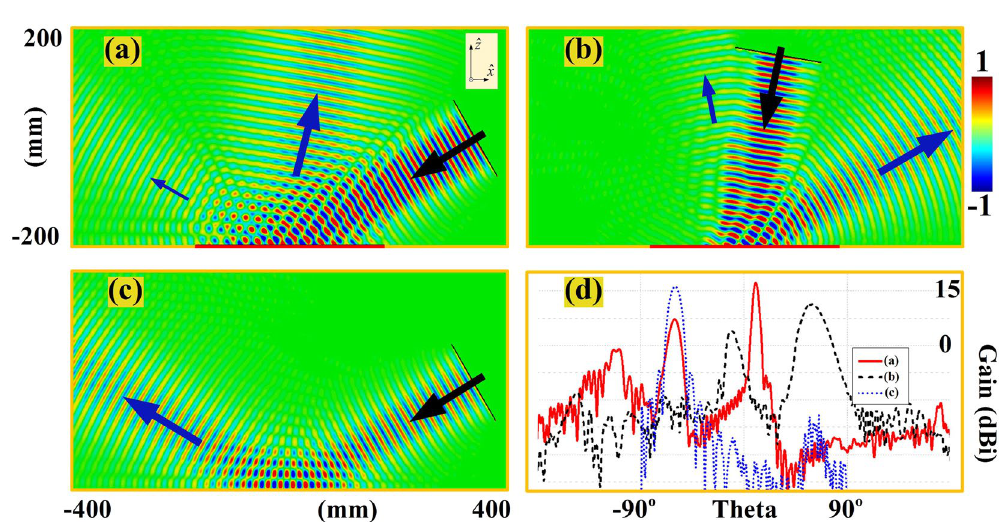
Figure 4. The radiation performances of the planar meta-mirror and conventional planar mirror. The meta- mirrors have the aperture of 345.6 mm with the incident plane wave from a 160 mm aperture wave port. ( a ) Planar meta-mirror with 60° incident plane wave. ( b ) Planar meta-mirror with 10° incident plane wave. ( c ) Conventional planar mirror with 60° incident plane wave. In ( a , b and c ), the real parts of E-fields are normalized by 550 V/m, 600 V/m, and 800 V/m respectively. ( d ) Far-field radiation patterns of the three cases in ( a , b and c